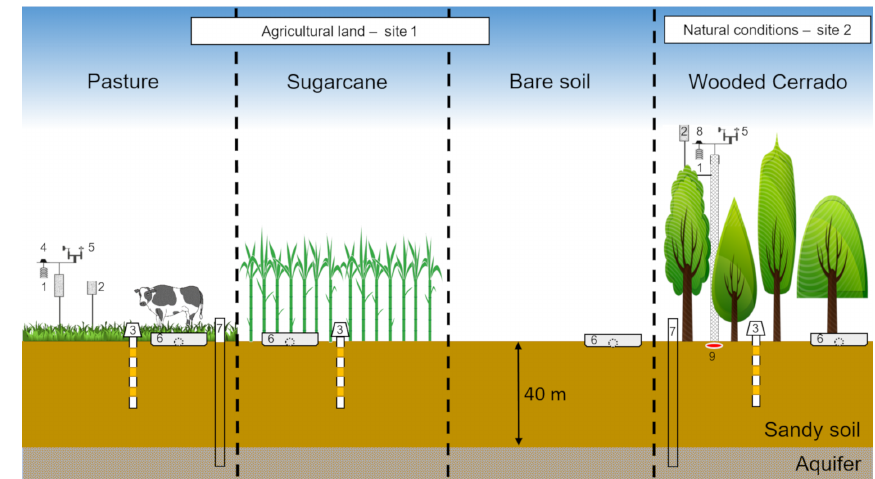
Figure 2. Hydrological monitoring performed on the four treatments: (1) relative humidity and air temperature probes at 2m (site 1) and 11m (site 2), (2) rainfall gauges, (3) soil moisture sensors, (4) solar radiation sensor, (5) wind speed and direction (anemometers) at 2m (site 1) and at 11m (site 2), (6) surface runoff collectors, (7) monitoring wells equipped with water table pressure transducers, (8) net radiation sensor, and (9) soil heat flux plate. Table 1. Monitoring site instrumentation